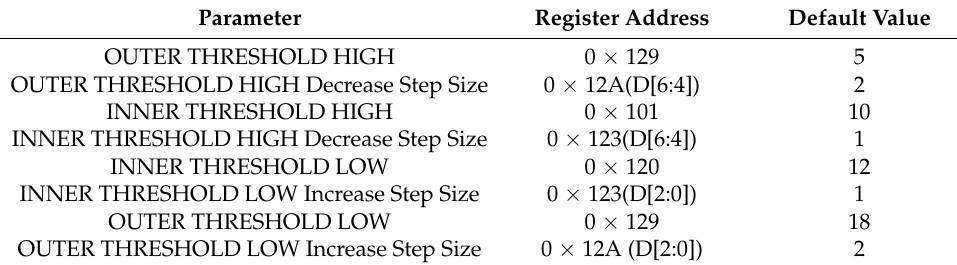
Table 1. Slow attack AGC parameters and related registers and their default values.